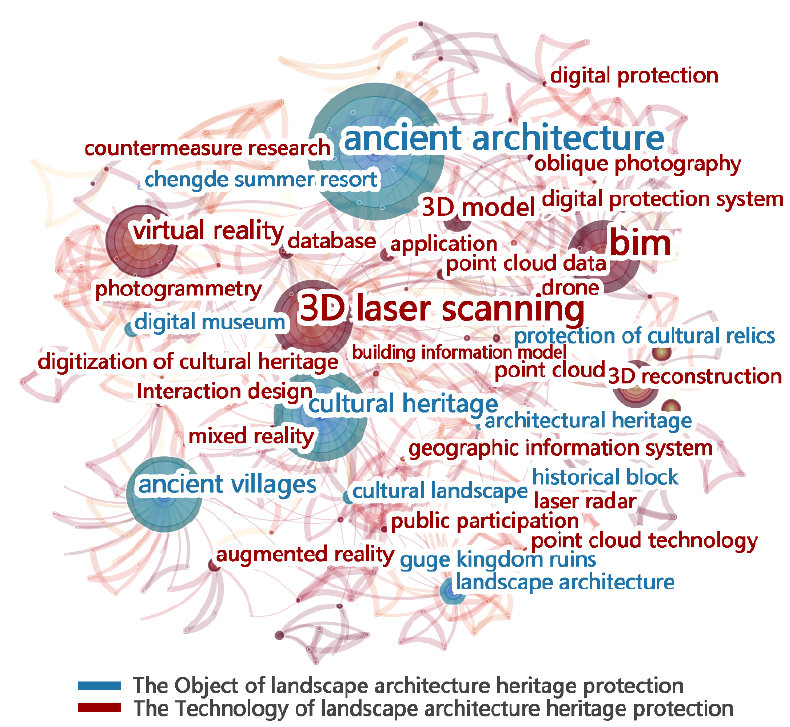
Figure 2. Co-occurrence of keywords of digital landscape architecture heritage protection.